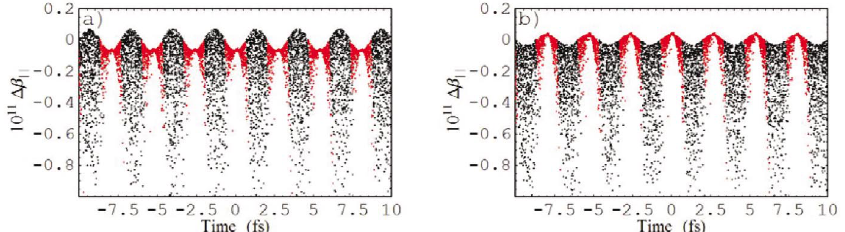
FIG. 7. (Color) A distribution of the electron longitudinal velocities in the case of the nonzero (cid:5) ! (see text): (a) (cid:5) ! (cid:1) 0 : 09 rad , (b) (cid:5) ! (cid:1) (cid:6) 0 : 03 rad .